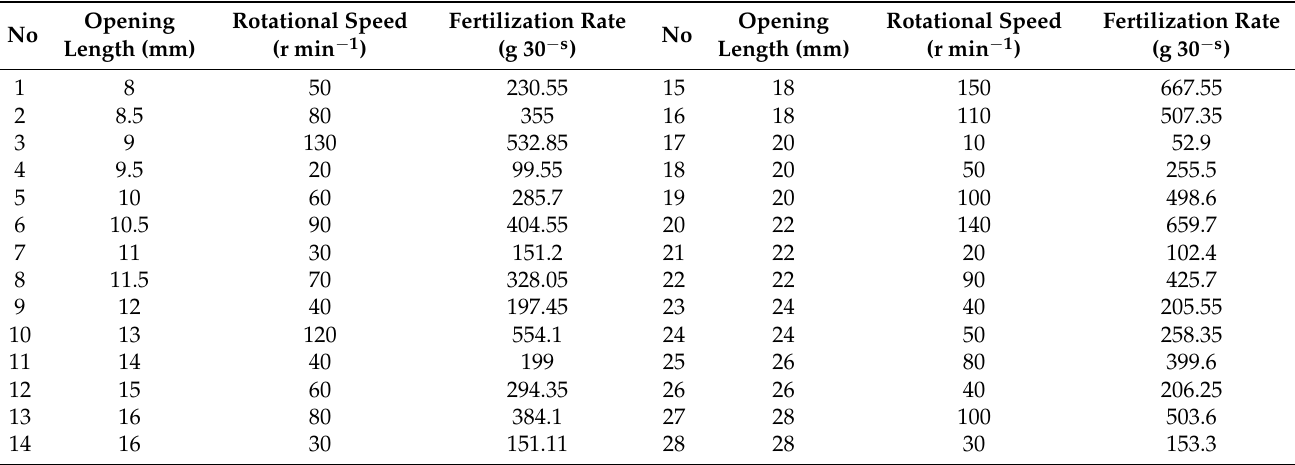
Table 7. Test set